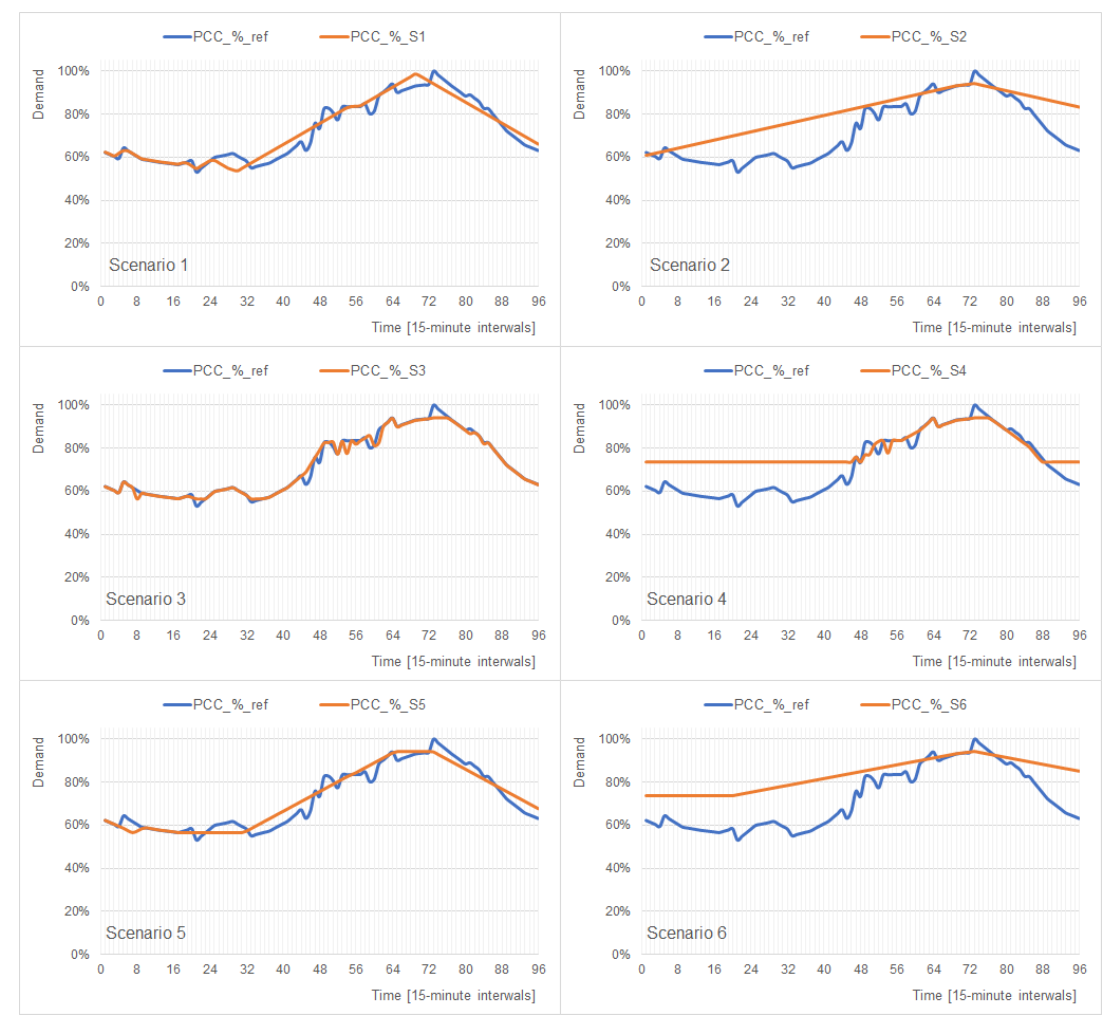
Figure 10. Results of Scenarios 1–6—power flow at the PCC.